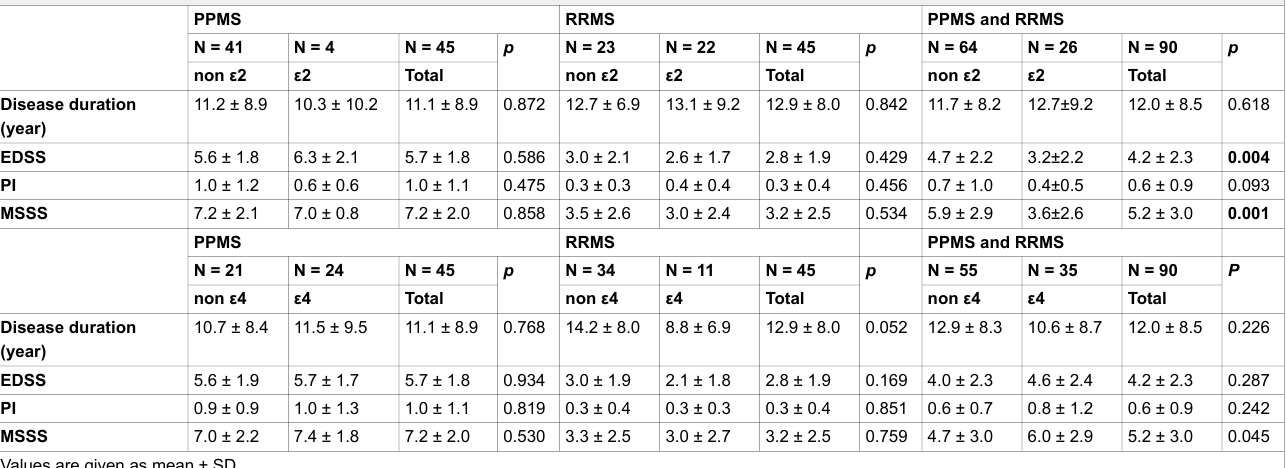
Table 5: Mean values of the measured clinical parameters of MS groups dependant on having or not having the ε2 or ε4